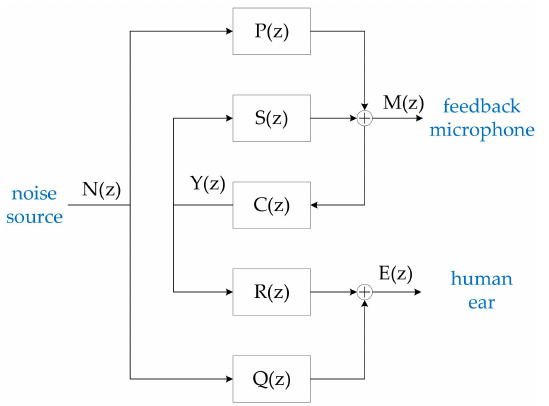
Figure 1. The schematic diagram of the feedback ANC